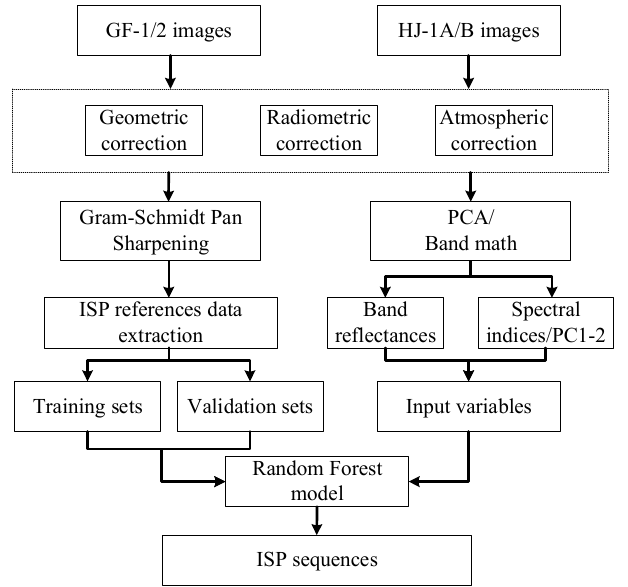
Figure 2. Flowchart of the study’s estimating procedure.